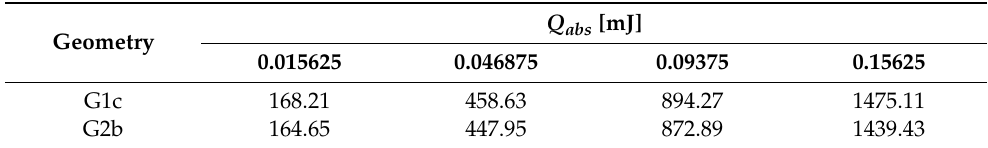
Figure 9. Time evolution of MLL (WC/SiC) maximum temperature for different absorbed energies: ( a ) geometry G1c; ( b ) geometry G2b. Table 6. Maximum MLL (WC/SiC) temperatures in K for two different geometries and different absorbed energies Q abs after 20 XFEL